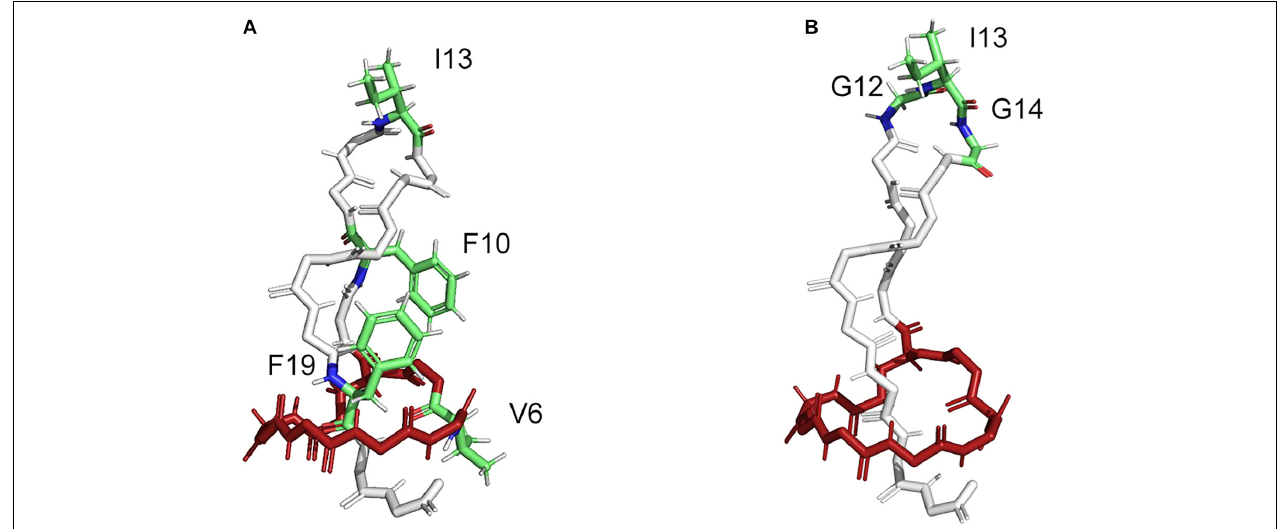
FIGURE 4 | Structure of MccJ25 with indicated modifiable positions (PDB code: 1Q71). (A) The modifiable positions (V6, I13, F10, and F19) in the core peptide region of MccJ25 as a natural scaffold used for grafting four non-canonical amino acids (ncAAs) (Piscotta et al., 2015). (B) The modifiable positions (G12-I13-G14) in the core peptide region of MccJ25 as natural scaffold used for grafting the bioactive RGD peptide epitope (Knappe et al.,